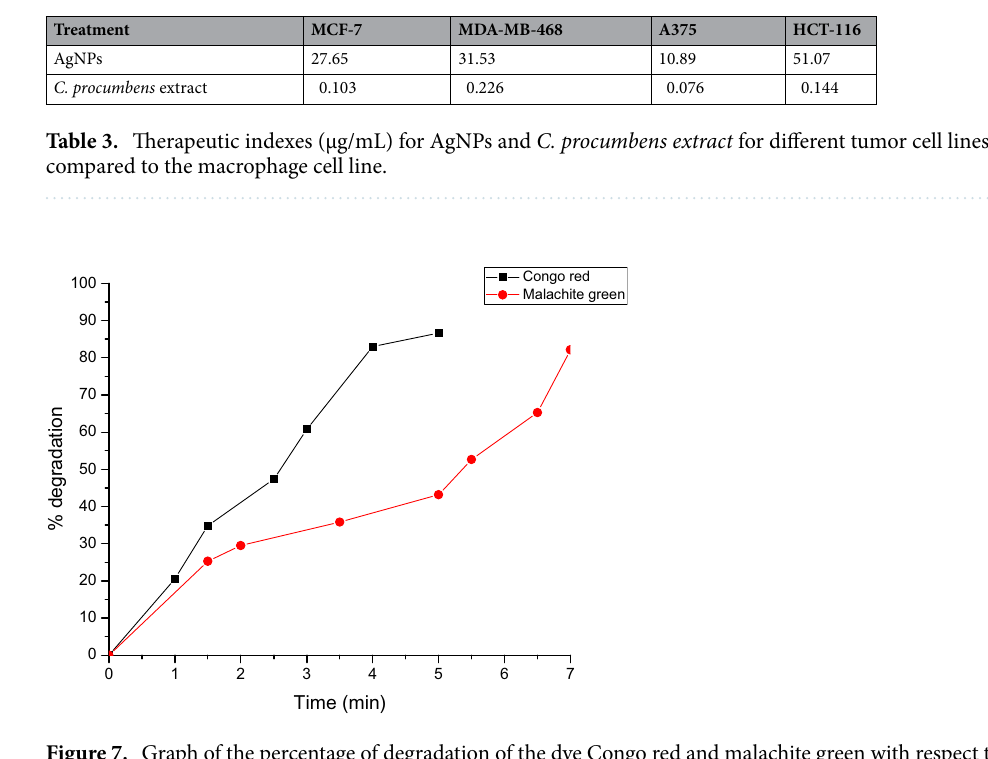
Figure 7. Graph of the percentage of degradation of the dye Congo red and malachite green with respect to